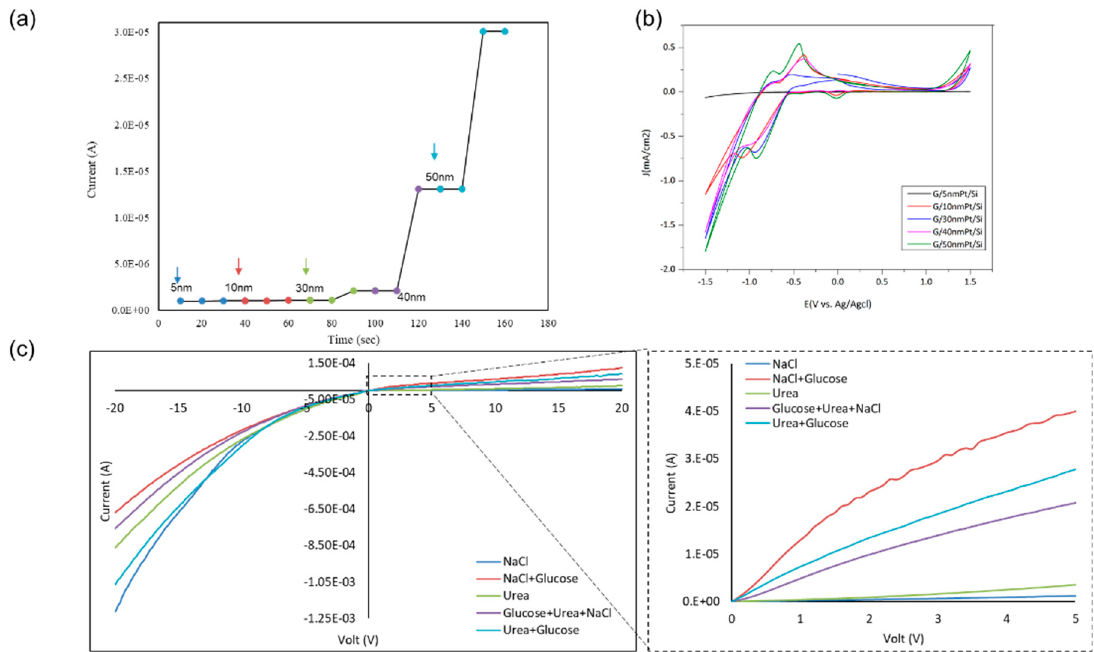
Figure 5. Testing 4 mM glucose on ( a ) testing 4 mM on different PtO thicknesses (5–50 nm), ( b ) cyclic voltammetry of di ff erent PtO thinkesses at a sweep − 1.5–1.5 V; ( c ) testing DI, NaCl, and urea characteristics of the structure in the presence of NaCl, urea, glucose, and mixtures.